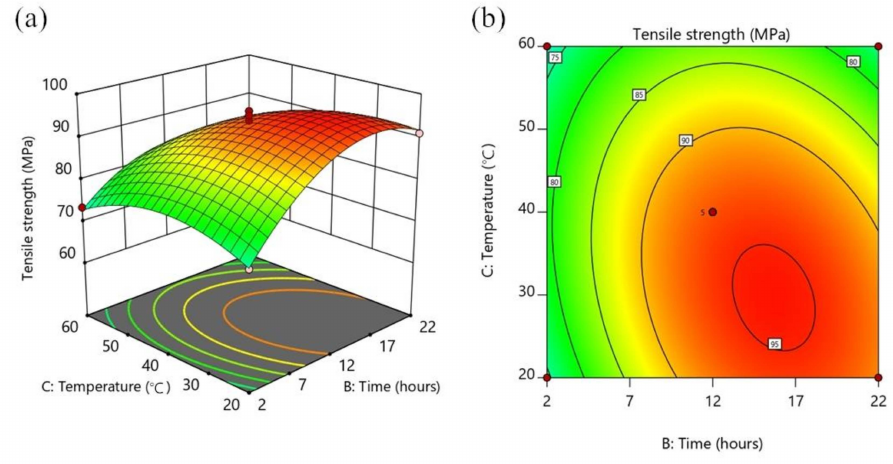
Figure 4. Effect of time and temperature on the tensile strength of coir fiber at a NaOH concentration of 6%: ( a ) three-dimensional surface plot; ( b ) contour plot.